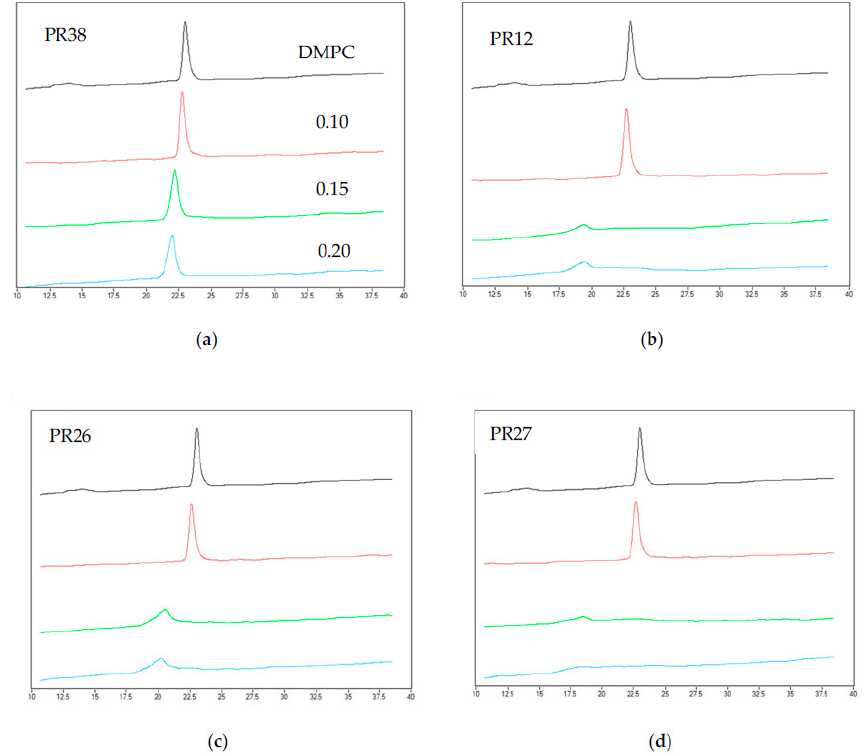
Figure 3. The example of thermograms obtained for DMPC mixed with compounds: ( a ) PR38, ( b ) PR12, ( c ) PR26, ( d ) PR27 as well as for pure lipid (the first curve from the top—black color). Curves in the figure represent the thermograms obtained for different molar ratios of the studied compound: DPPC (from the top to the bottom 0, 0.1, 0.15, 0.2).